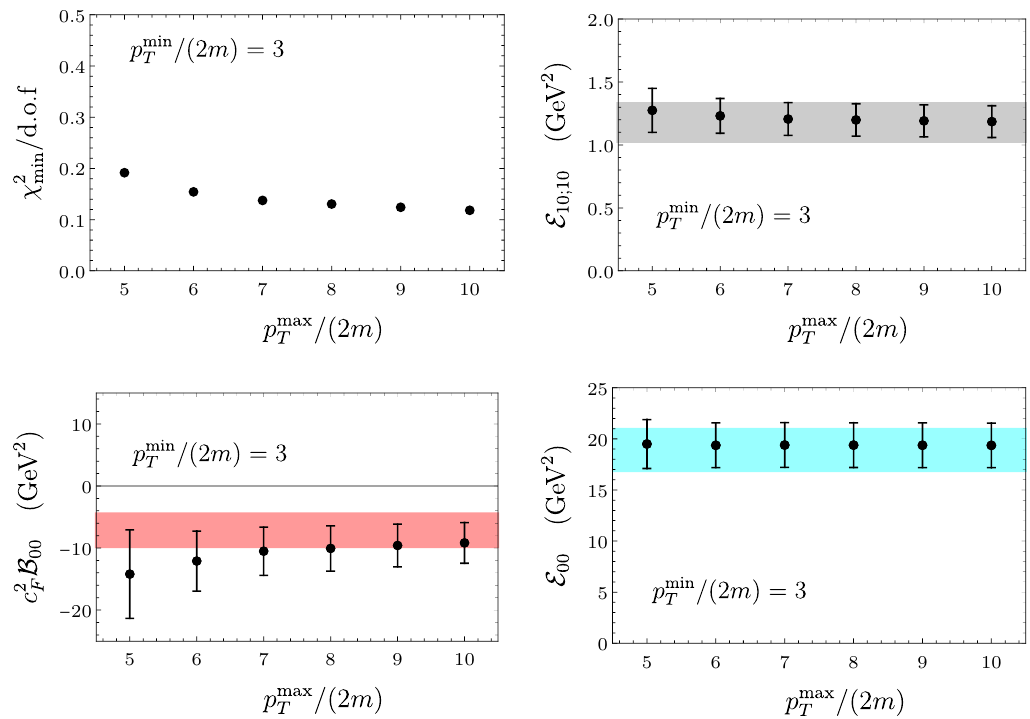
of the χ 2 / d . o . f , and the values of E 10;10 , c 2 B 00 , min T F / (2 m ) = 3 . The E 10;10 and B 00 are T / (2 m ) = 3 T